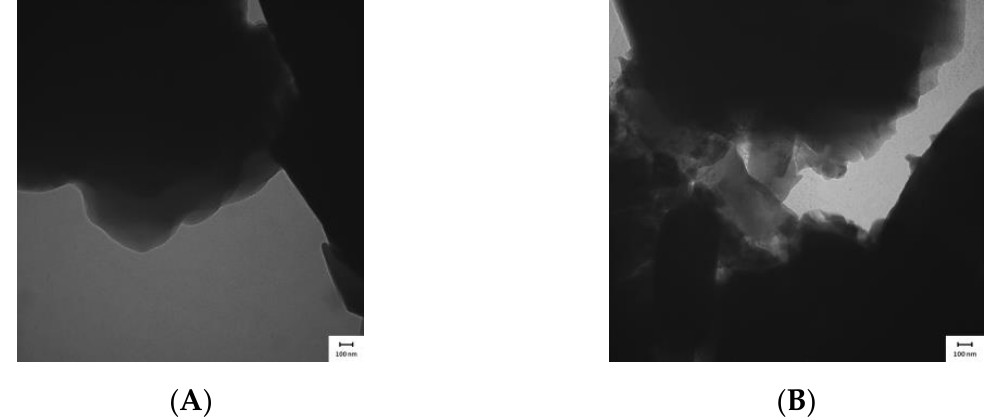
Figure 7. Transmission electron micrographs of ( A ) Zn-AlPO 4 and ( B ) AlPO 4 heat-treated at 400 °C.